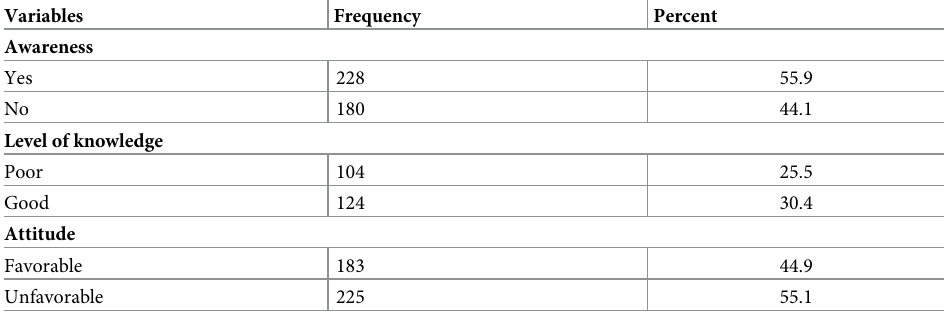
Table 2. Awareness, knowledge and attitude about corneal donation of patients attending Gondar University Comprehensive and Specialized Hospital, July 2020. Variables